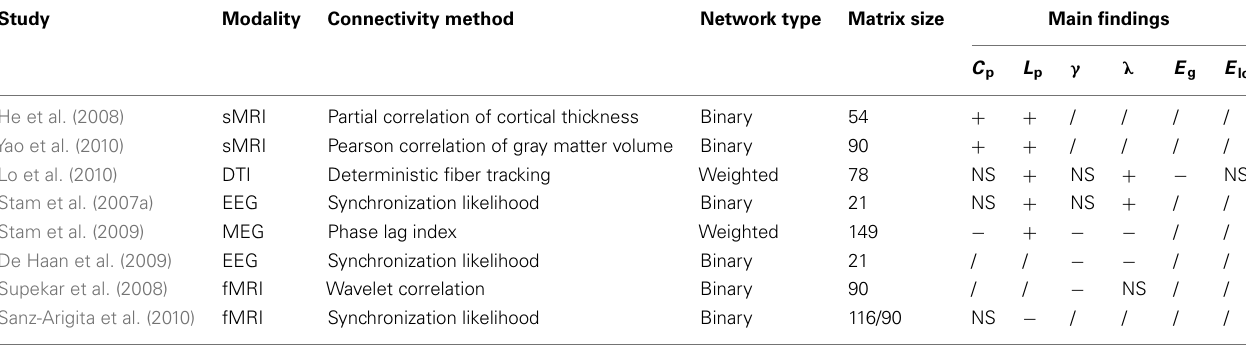
Table 2 |Alzheimer’s disease-related alterations of topological